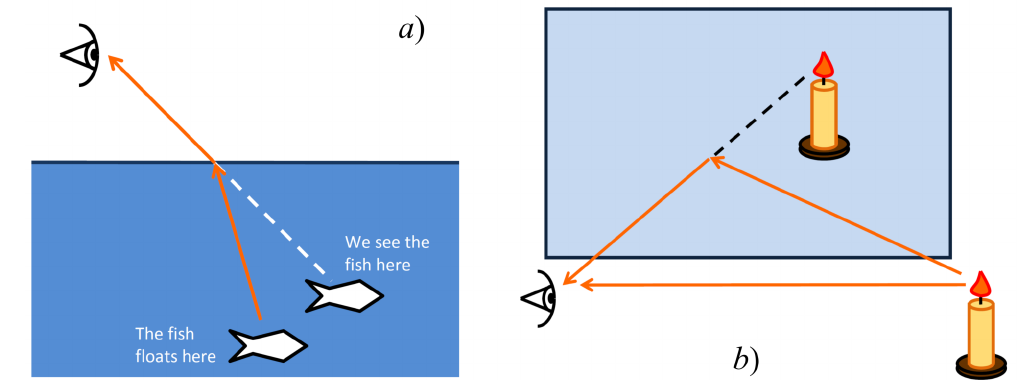
Figure 1. Effects similar to the effects of gravitational lensing but arising from the non-homogeneity of the medium: ( a ) Change in the visible position of the object due to the refraction of light at the interface between two media. ( b ) The emergence of two images of the same object when placed near a